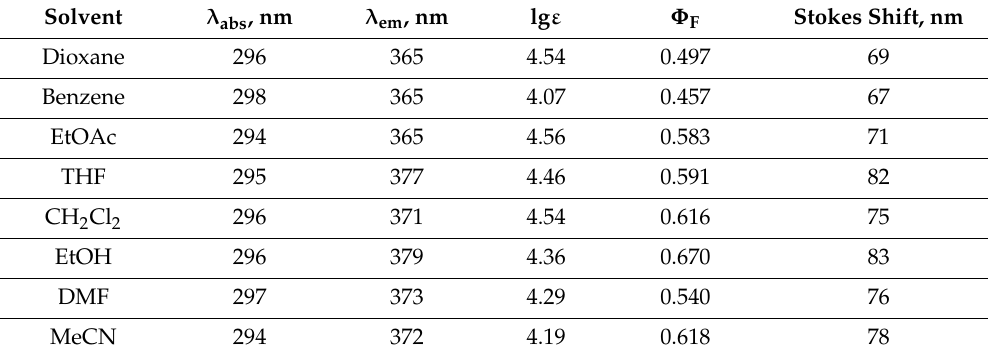
Table 3. Quantum yields and Stokes shifts of 4l in di ff erent